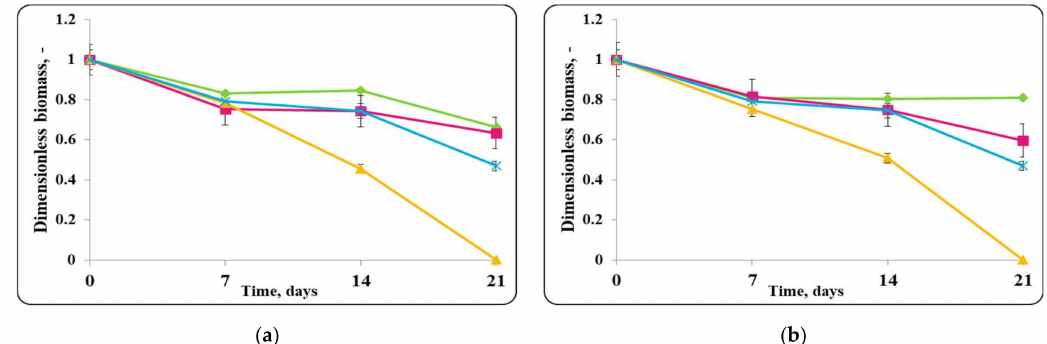
Figure 3. ( a ) free lactobacilli cells; ( b ) encapsulated lactobacilli cells. Changes in the dimensionless biomass of Lb. helveticus 2/20 and E. coli ATCC 25922 in MRS broth at 4 ± 2 ◦ C. Legend: Green (cid:117) : Lb. helveticus 2/20 population following its inoculation; Pink (cid:4) : Lb. helveticus 2/20 population following its co-inoculation with E. coli ATCC 25922; Blue × : E. coli ATCC 25922 population following its direct inoculation; Yellow (cid:78) : E. coli ATCC 25922 population following its co-inoculation with Lb. helveticus